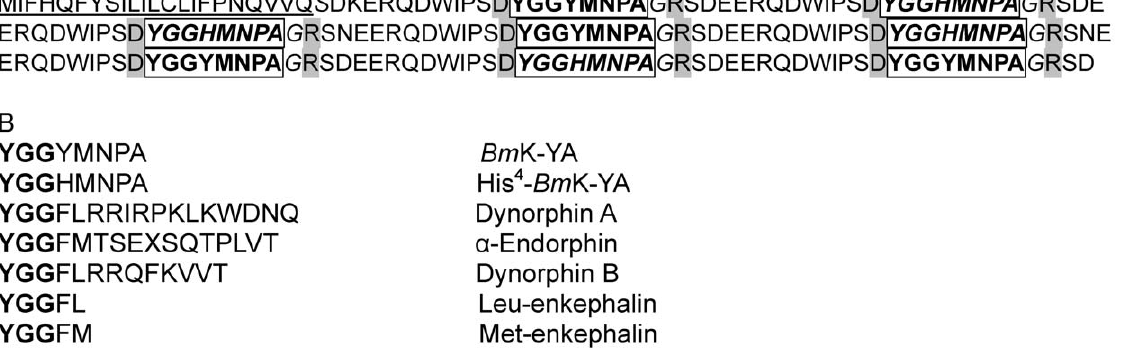
Figure 3. (A) Amino acid sequence of the Bm K-YA precursor. The signal peptide is underlined. The amino acid in grey indicates cleavage sites (R, D). The glycine residues expected to serve as amide donors are shown in italic. The sequences of Bm K-YA and His 4 - Bm K-YA (italic) are framed in bold. (B) Comparison of Bm K-YA and His 4 - Bm K-YA to the opioid peptides. Identical amino acid residues are shown in bold.